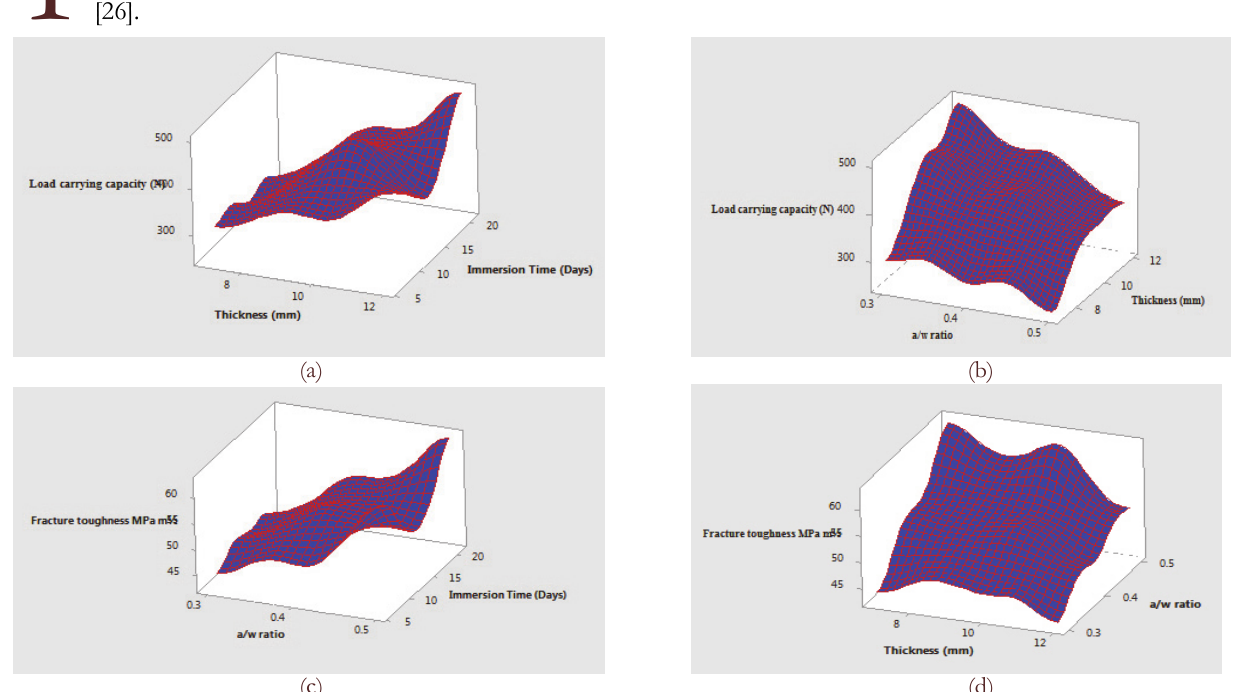
Figure 5: RSM graphs of different control factors V/S Load and Fracture toughness of ENT Test